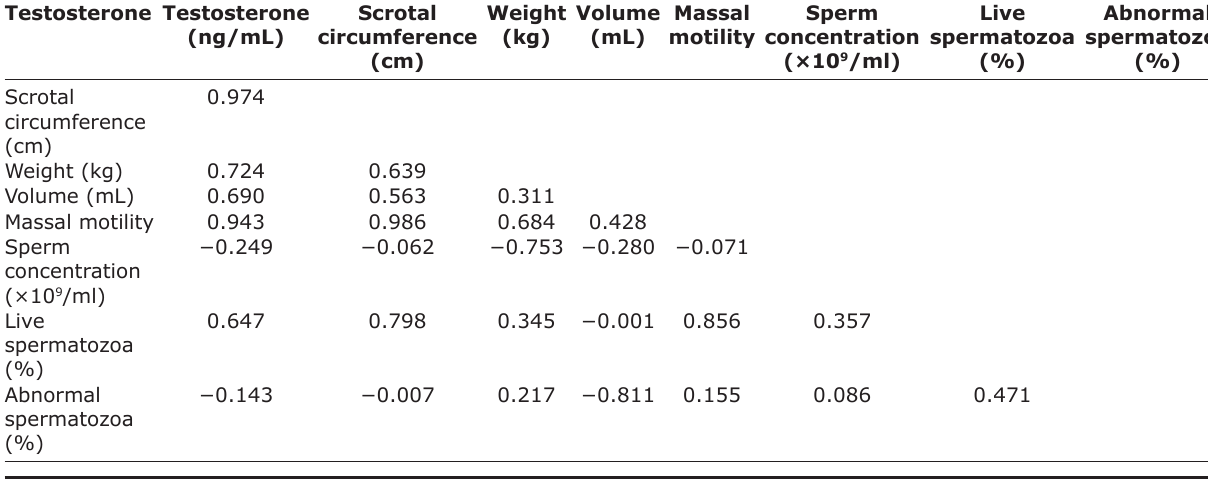
Table-4: Pearson’s correlation between testosterone, scrotal circumference, and sperm parameters. Testosterone Testosterone (ng/mL)